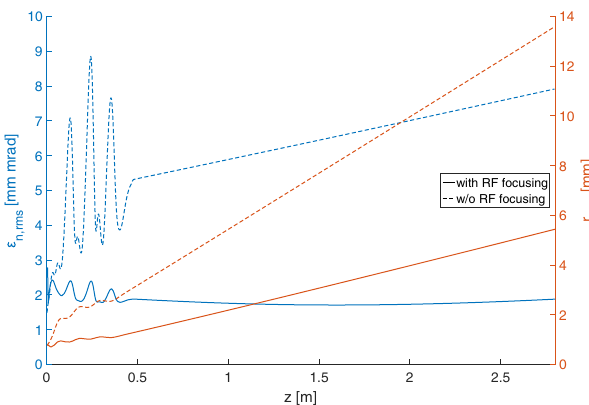
FIG. 10. Tracking of a 250 pC bunch through the ELBE SRF Gun and along the first 2.8 meters of the beamline with deactivated solenoid. The dashed curves give the evolution of beam radius and transverse emittance for a case without rf focusing while the solid curves include optimization of the retraction of the photocathode in the half